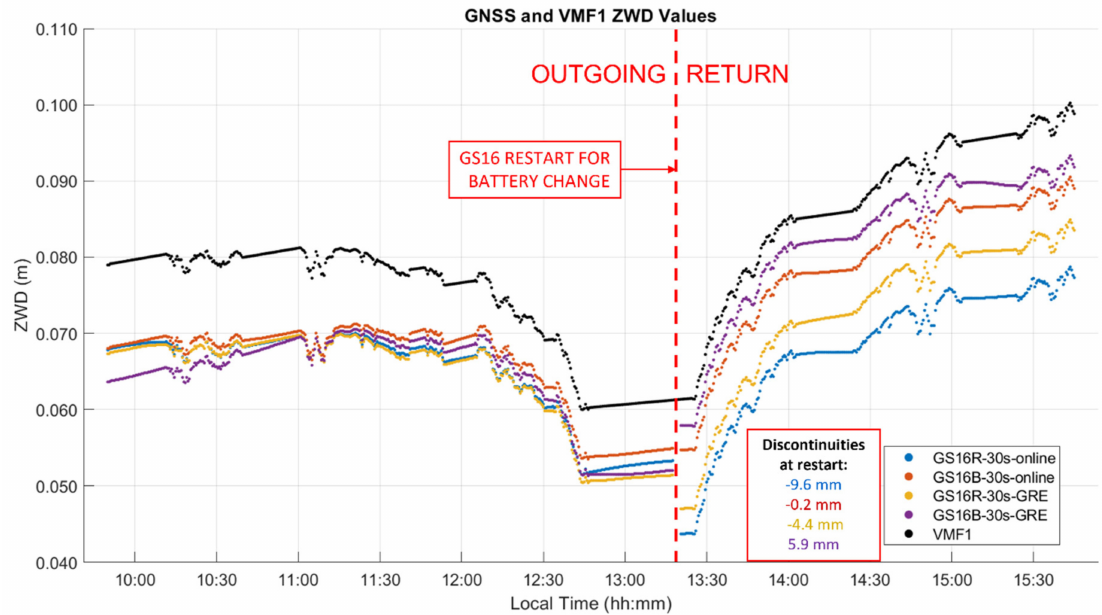
Figure 14. Kinematic dataset B ZWD profiles of outgoing and return trajectories. Local time is UTC −